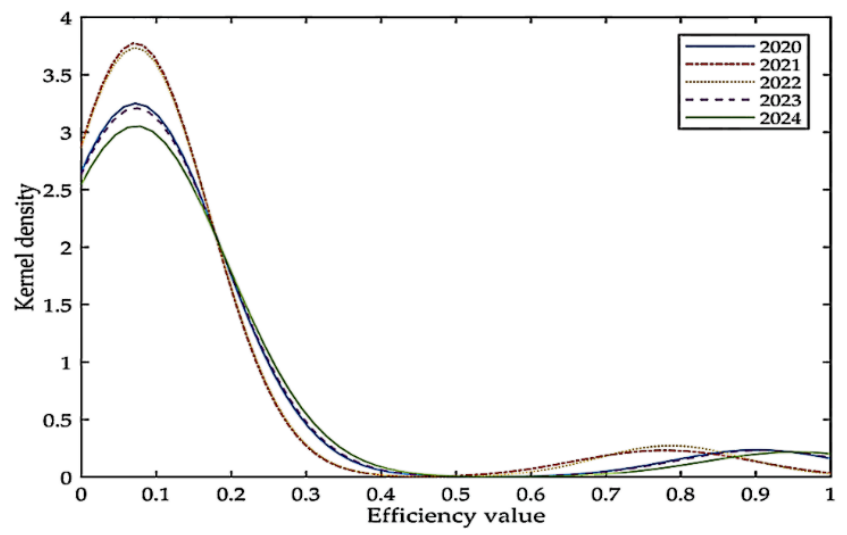
Figure 1. Kernel density estimates of low-carbon economic efficiency values in China.